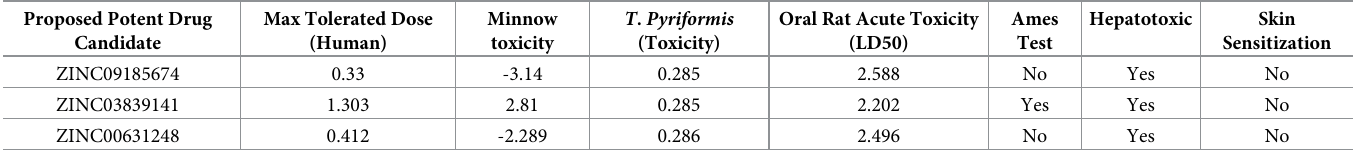
Table 6. Toxicity analysis: Assessment of toxicity of shortlisted 3 compounds. Proposed Potent Drug Candidate